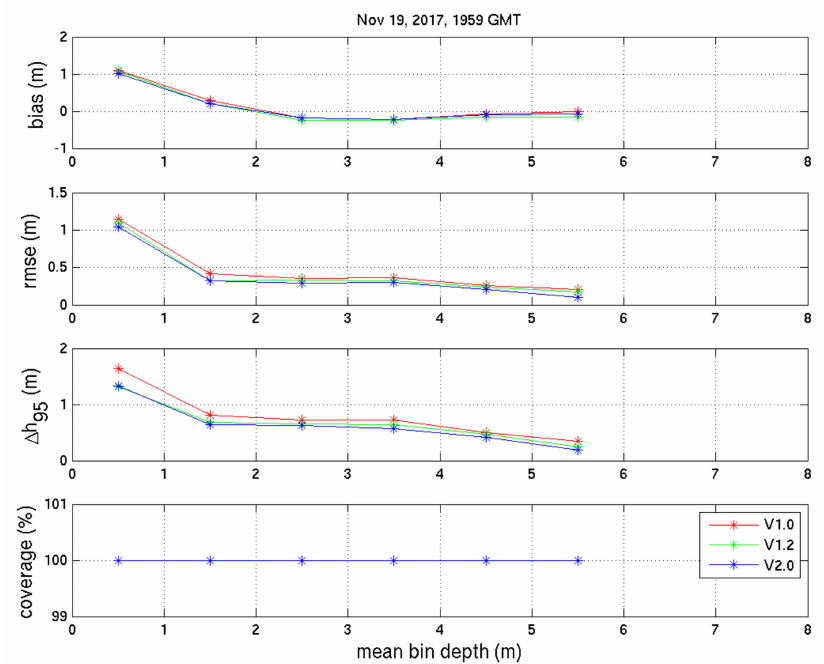
Figure 21. The four basic performance statistics plotted versus surveyed depth for the example survey date of 19 November 2017. Note that each plot includes three lines, one for each algorithm, with the third (blue) often overplotting the others.